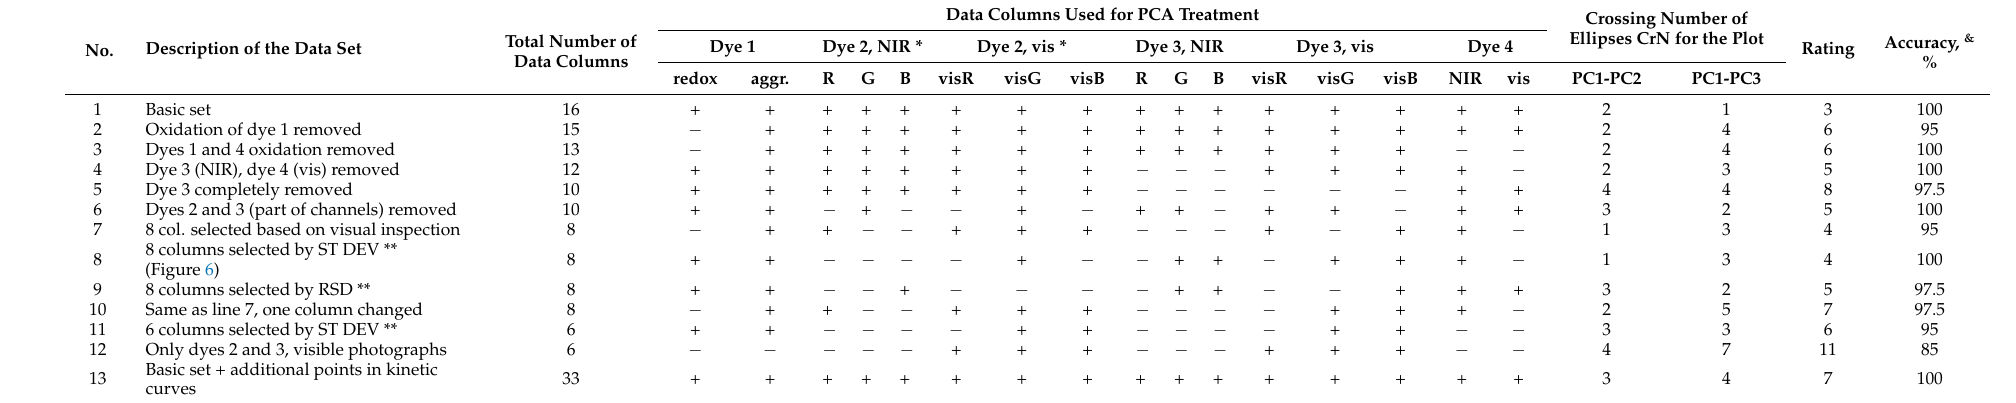
Table 2. Discrimination efficiency of nine analytes represented as the number of intersections of confidence ellipses CrN and total rating for various data sets